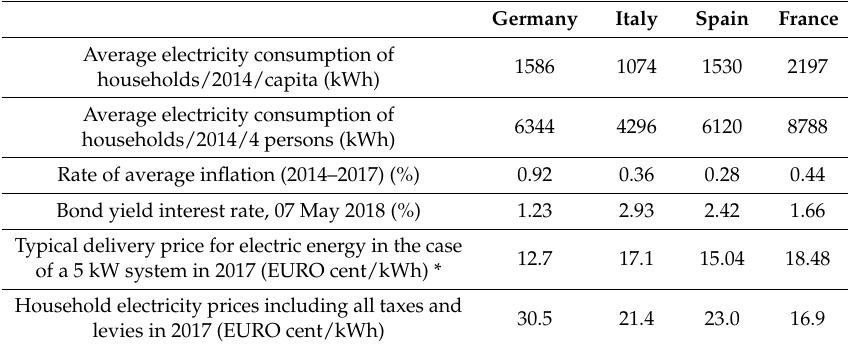
Table 3. Bond yield interest rates, delivery price of electric energy and the electricity consumption of an average household in the analyzed countries [50,85,87–93,97].